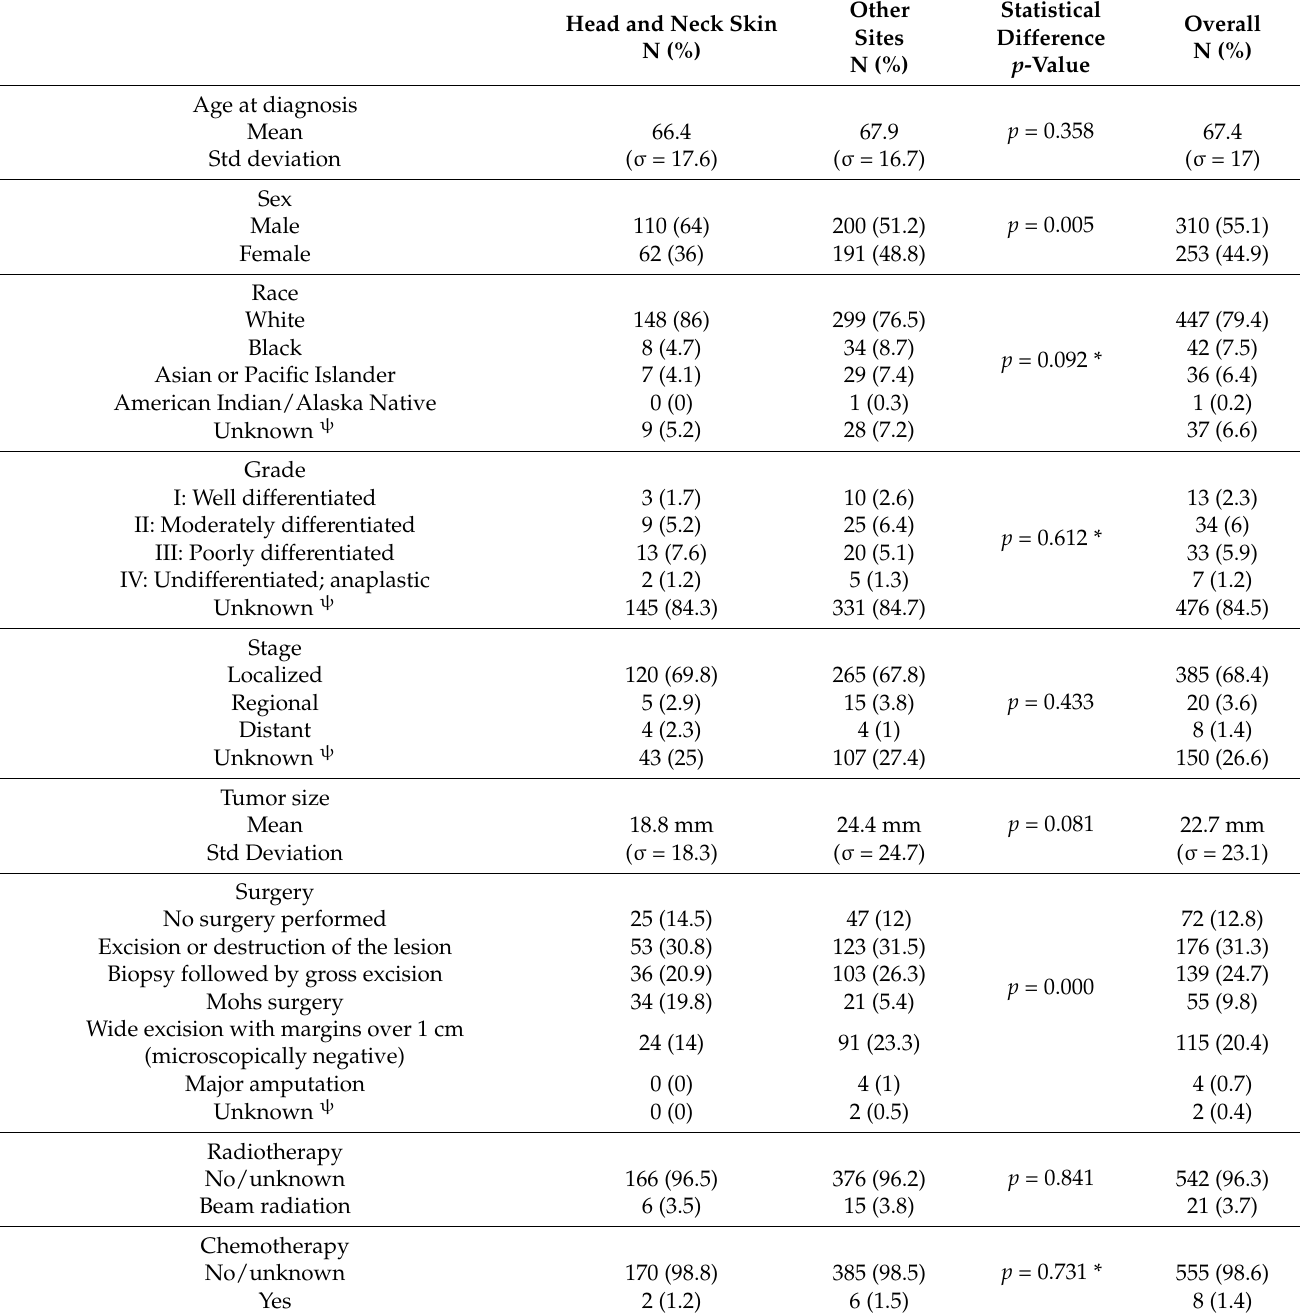
Table 1. Demographic, pathological, and treatment characteristics of the study population affected by porocarcinoma. Head and Neck Skin N